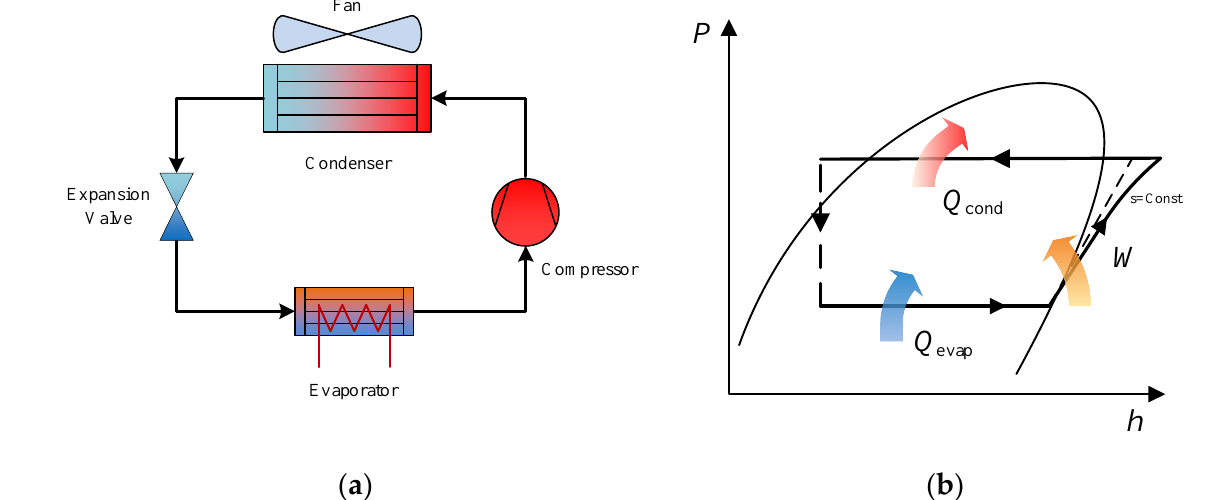
Figure 11. Schematic diagram and pressure – enthalpy diagram of vapor cycle refrigeration system. ( a ) Schematic diagram. ( b ) Pressure – enthalpy diagram.